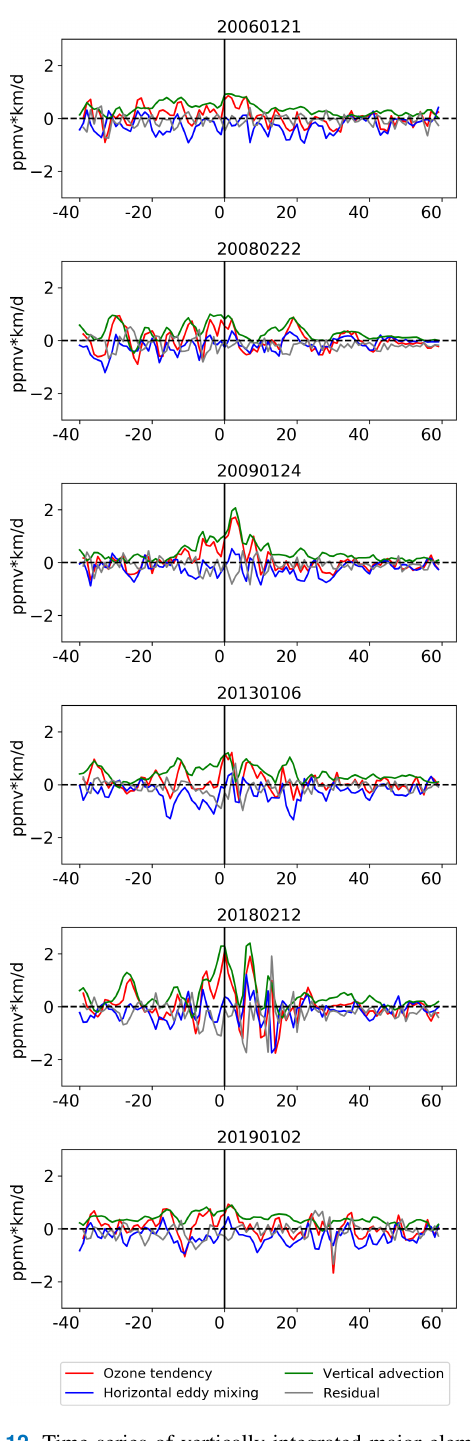
Figure 12. Time series of vertically integrated major elements of tracer continuity (Eq. 2) from 15 to 30km (Andrews et al., 1987). Ozone tendency is shown by the red line. The horizontal component of eddy mixing is shown by the blue line, and the vertical compo- nent of vertical advection is shown by the green line. The residual of all elements of tracer continuity is shown by the gray